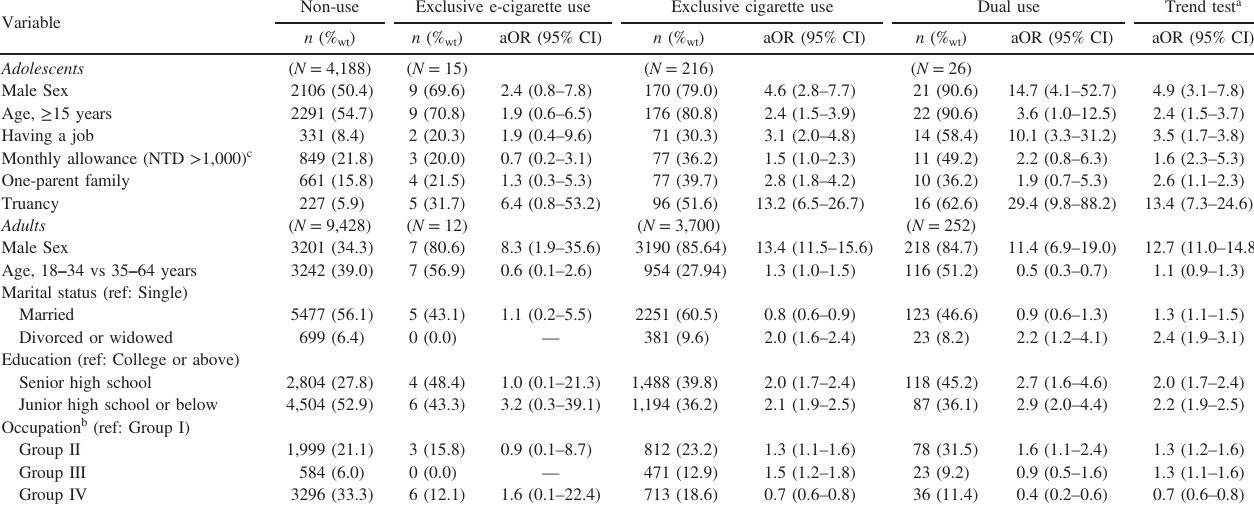
Figure 1. The distribution of the new e-cigarette users ( N = 265) in the 2014 National Survey of Substance Use in Taiwan. Individuals whose self-reported initiation of e-cigarettes occurred before 2005, the year of initial introduction of e-cigarettes into the market, were not included in this analysis ( n = 40). Three separate regression analyses were conducted for the period of 2005 – 2008, 2008 – 2011, and 2011 – 2014. Comparing the regression coe ffi cients (B) of adjacent time periods, with the di ff erence divided by the square root of the sum of the two squared standard errors (se), there was an increase from 2005 – 2008 to 2008 – 2011 (Z = 2.43; P = 0.008), and a tendency of increase from 2008 – 2011 to 2011 – 2014 (Z = 0.61; P = 0.27). Table 3. Multivariable multinomial logistic regression of tobacco usage groups, using people with non-use as the reference group, on sociodemographic features in the 2014 National Survey of Substance Use in Taiwan Variable